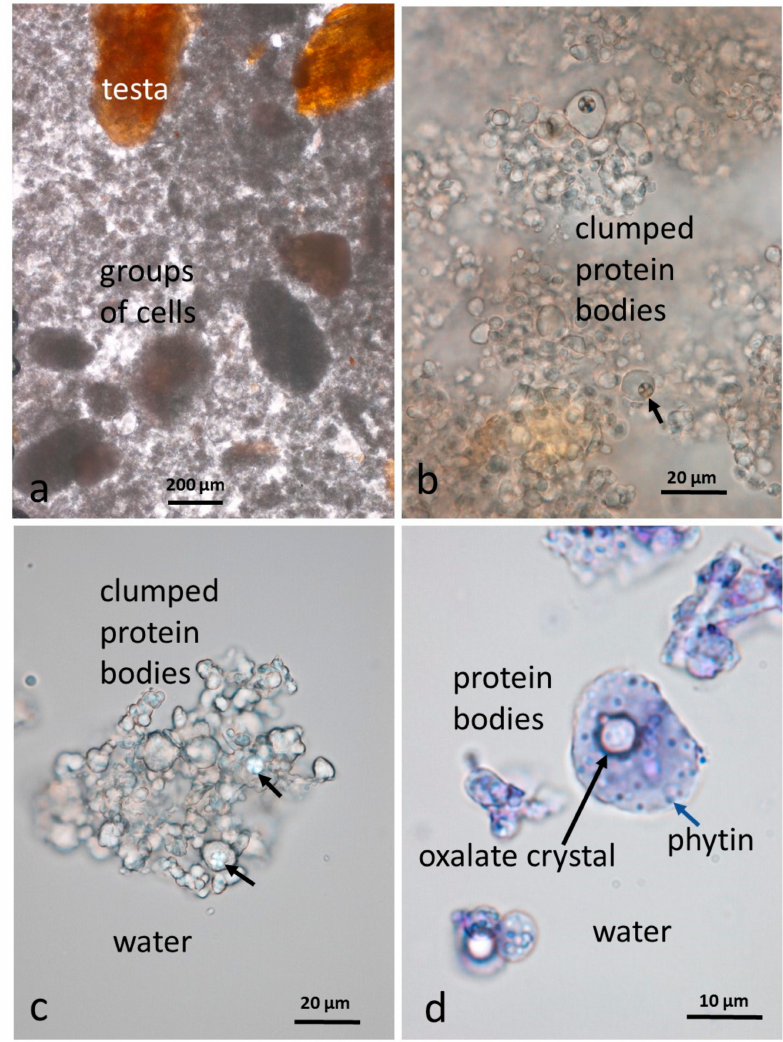
Figure 4. Almond butter baseline sample de-oiled in chloroform/methanol: ( a ) The butter contains clumps of kernel cells and testa fragments; ( b , c ) individual protein bodies form clumps with some containing small crystals of calcium oxalate (black arrows) visible under polarising optics; ( d ) protein bodies stained with dilute toluidine blue showing an oxalate crystal and phytin globoids (blue arrow) found in the larger protein